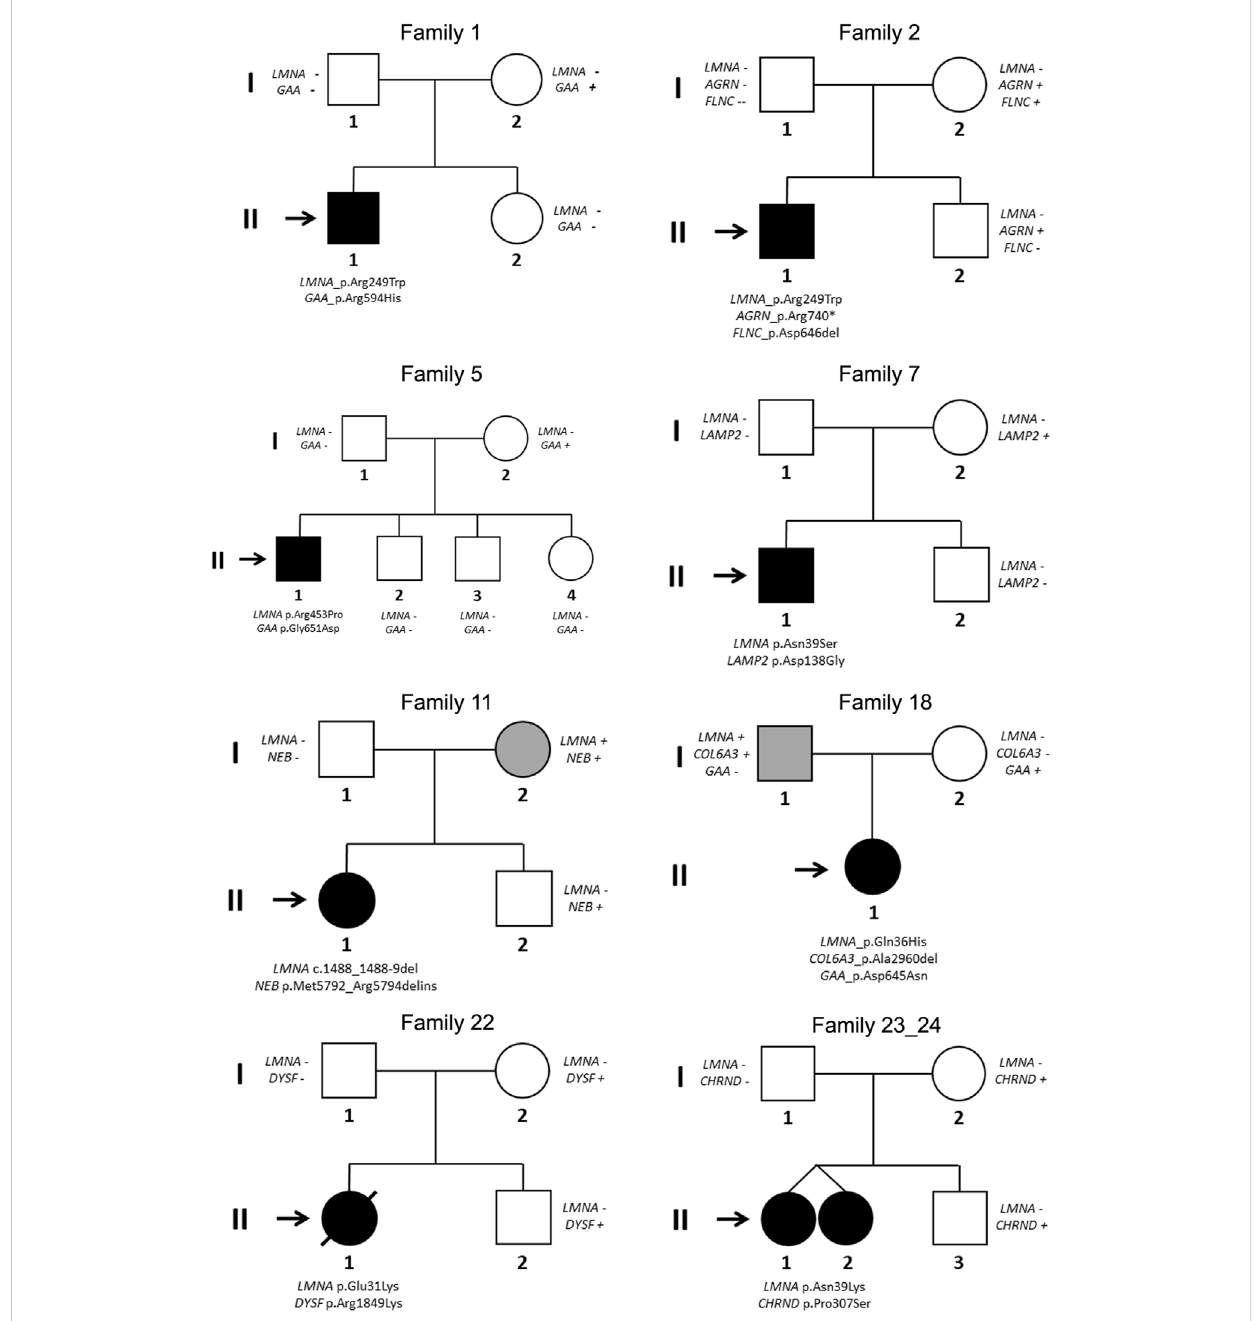
with a number. Clinically affected patients are shows in black, clinically unaffected patients are show in white, and mild phenotype is indicated in grey color. Slash indicates deceased. Index case is indicated with an arrow. Sign plus indicates carrier of the genetic variant. Minus sign indicates not carrier of the genetic